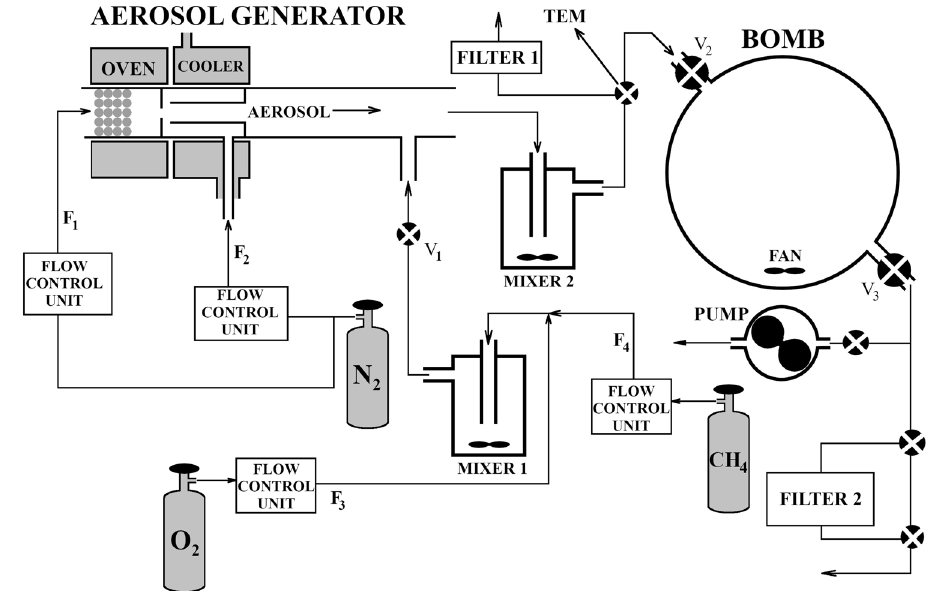
Fig. 2 Schematic of ignition experiments